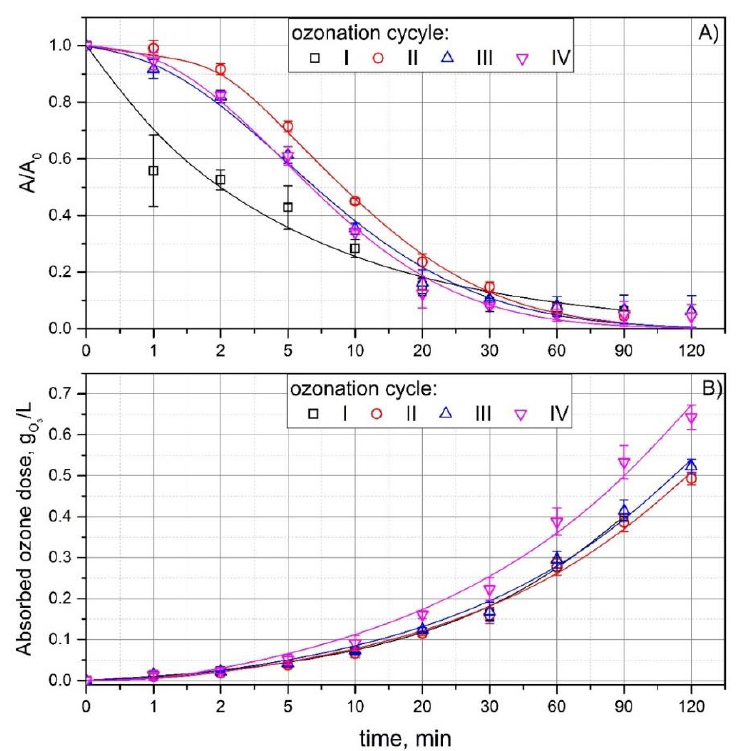
Figure 3. Ozonation from cycles I to IV, Q 0.66 L/min, C O3 42.3 mg/L: ( A ) color removal (A/A 0 ), ( B ) absorbed ozone dose mg O3 /L.